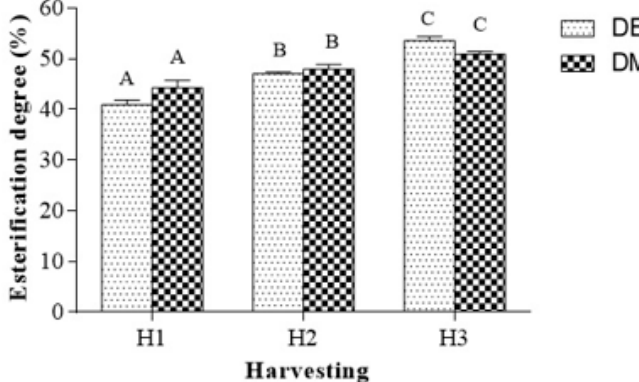
Figure 3. E ff ects of harvesting (H1, H2, and H3) on esterification degree determined by titrimetric (esterification degree determined by titration method, DE) and instrumental methods (esterification degree determined by instrumental FTIR method, DM). Error bars represent standard deviation (n = 3). Values with the same letter are not significantly di ff erent, while values with di ff erent letters are significantly di ff erent (DE: H1 vs. H2, ** p < 0.01, H1 vs. H3, **** p < 0.0001, H2 vs. H3, ** p <